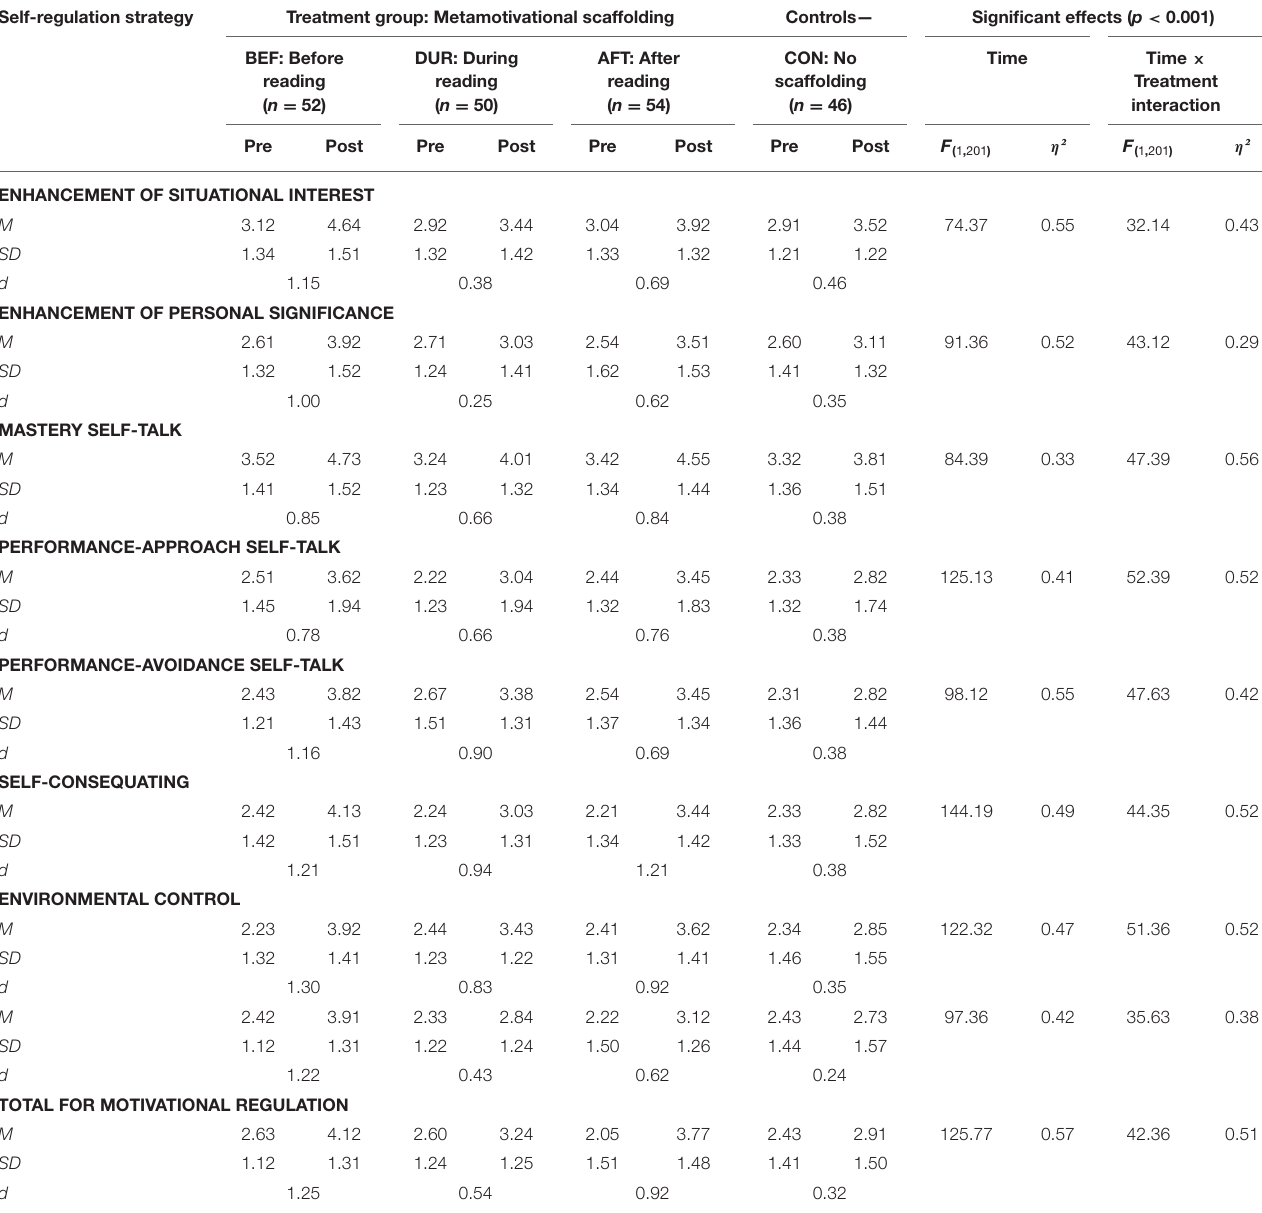
TABLE 7 | Means, standard deviations, and cohen’s d effect sizes a of motivational regulation strategies, by time and treatment, with significant effects. Self-regulation strategy Treatment group: Metamotivational scaffolding Controls— Significant effects ( p < 0.001)